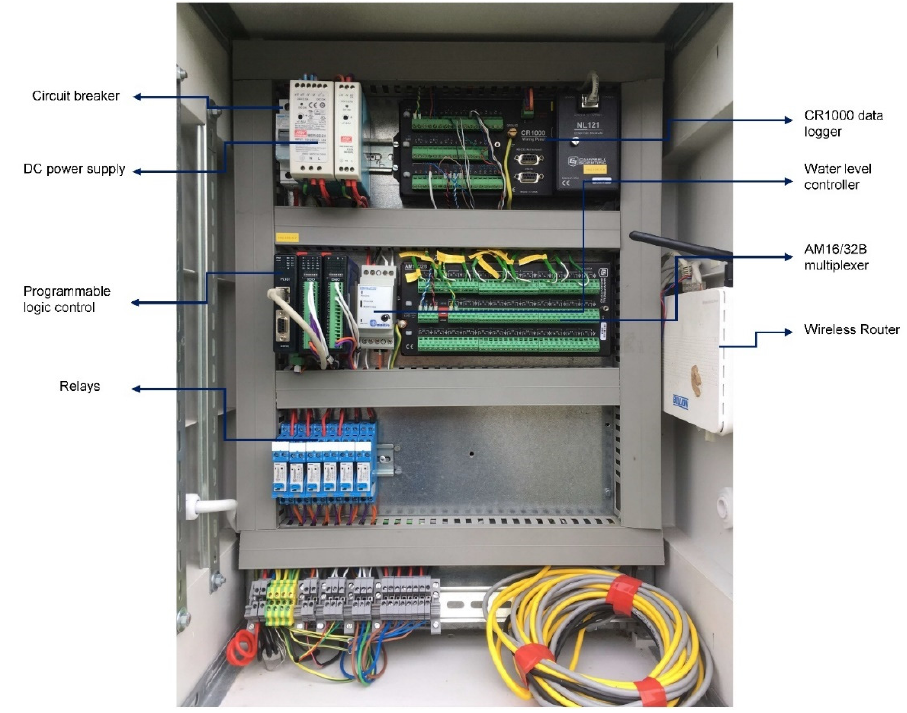
Figure 4. Data acquisition and control system for the high- and low-pressure solar water heater systems.